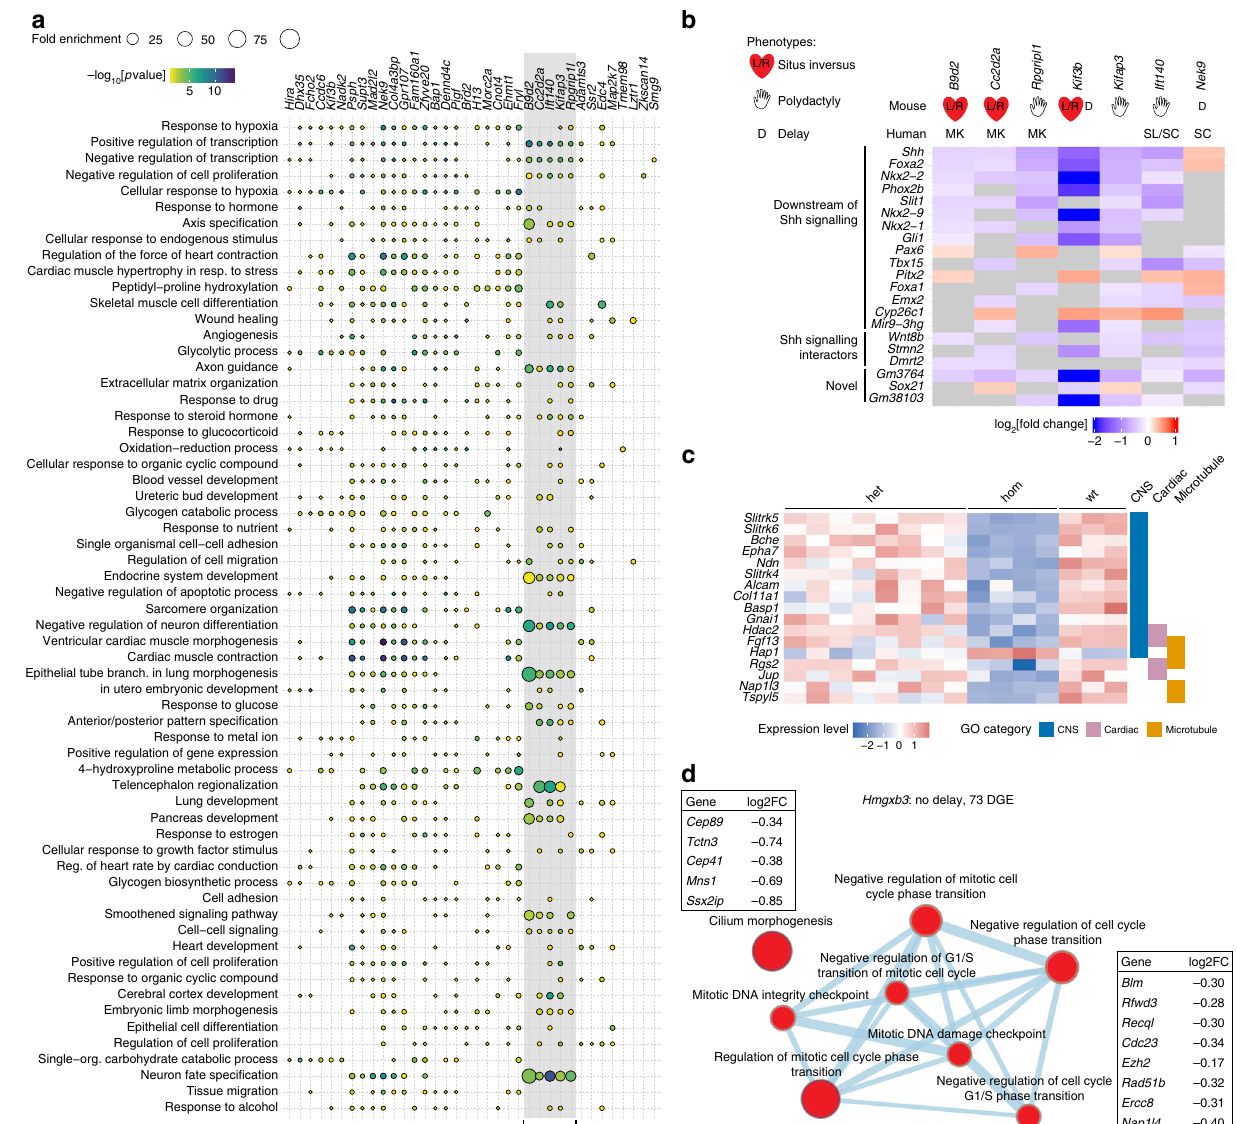
Fig. 5 Mutant response overview and examples. a Bubble plot of the enriched Gene Ontology (GO) terms shared across most mutant lines, with lines on the x -axis and GO terms on the y -axis. The ordering of mutants on the x -axis was determined by hierarchical clustering of the overlap (Jaccard Index) of terms between lines. The size of the bubbles represents fold enrichment (Observed Genes/Expected) and they are coloured by − log 10 [ p value]. The group of ciliopathy mutants are highlighted with a grey box and a bar at the bottom. b Heatmap of the log 2 [fold change] of genes that are differentially expressed (DE) in at least four of the seven mutants identi fi ed as having similar ciliopathy pro fi les. Mutant lines are shown on the x -axis and DE genes on the y -axis. Phenotypes associated with mutations in human and mouse are shown above the heatmap. The DE genes have been categorised into three groups, Downstream of Shh signalling, Shh signalling interactors and Novel. c Heatmap of 17 DE genes from the Zkscan17 mutant line associated with central nervous system (CNS), cardiac or microtubule GO terms. The heatmap displays expression values as mean centred and scaled normalised counts in all samples and the GO categories associated with each gene are shown to the right of the heatmap. d Network diagram produced by Enrichment Map (Cytoscape App) of the GO term enrichment in the Hmgxb3 mutant line. The nodes represent enriched GO terms and the edge widths are proportional to the overlap of genes annotated to each term. Not all enriched GO terms are included. Source data are provided as a Source Data fi